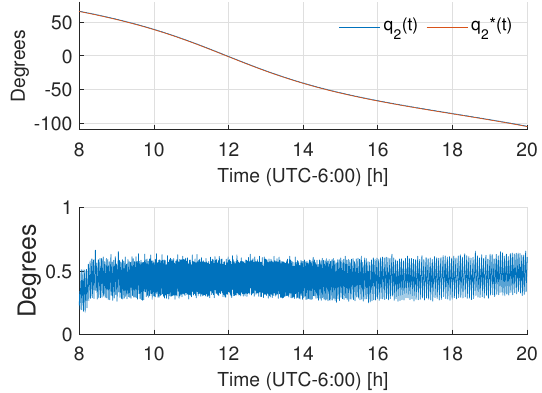
Figure 15. Tracking behavior for the elevation axis (PID control).